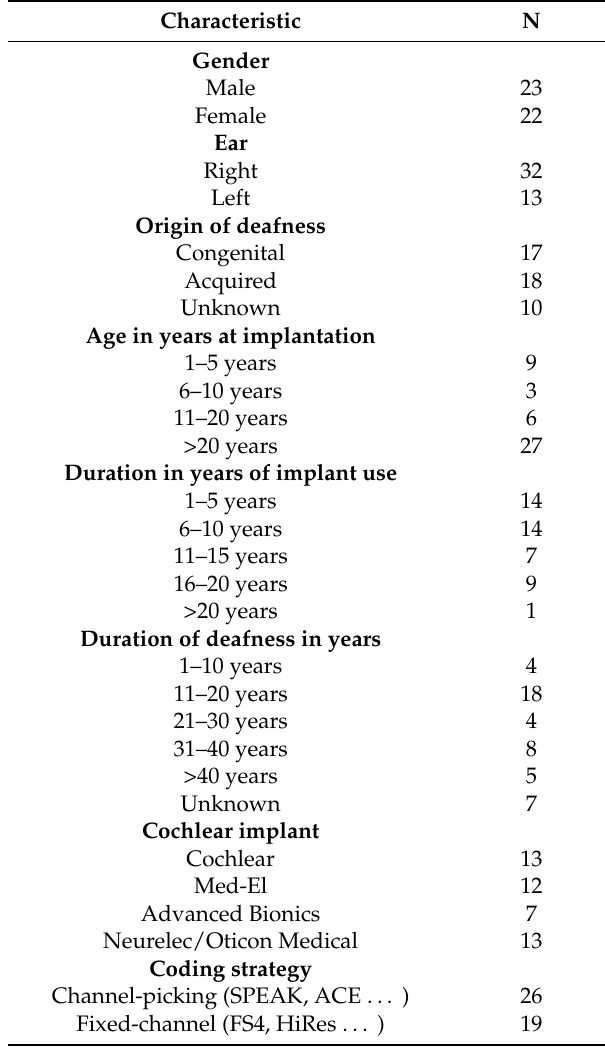
Table A1. Demographic details for cochlear implant